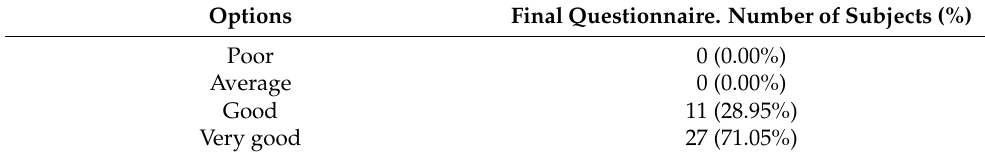
Table 8. Item 6: Professor assessment when explaining how to solve dose calculation problems.